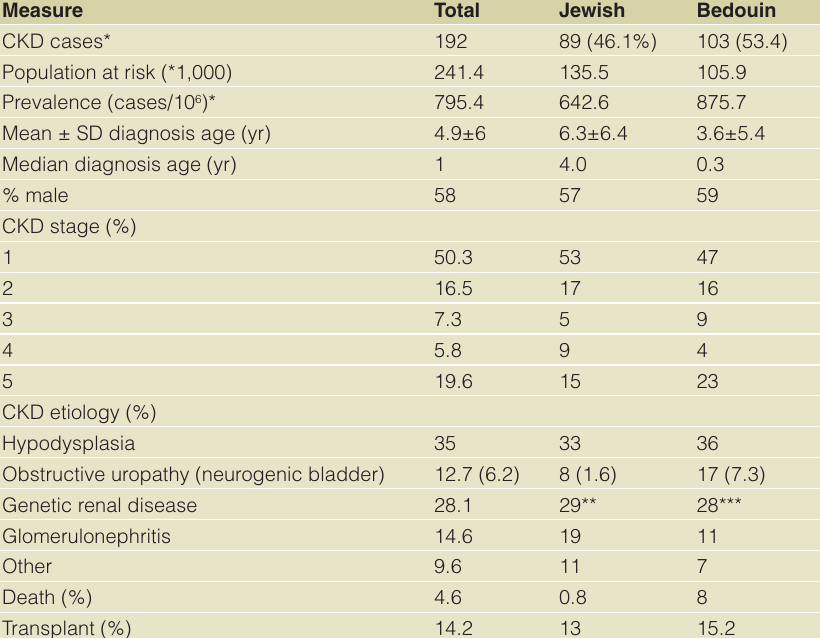
Table 1. Southern Israel pediatric chronic kidney disease (CKD stages 1–5), based on the retrospective analysis. * Refers to living patients aged < 19 years on December 2008. Prevalence is adjusted for age. ** Mostly autosomal dominant polycystic kidney disease (ADPKD); *** Mostly atypical hemolytic uremic syndrome and infantile nephronophtisis. No p values for comparison are provided since the total population (and not a sample) is